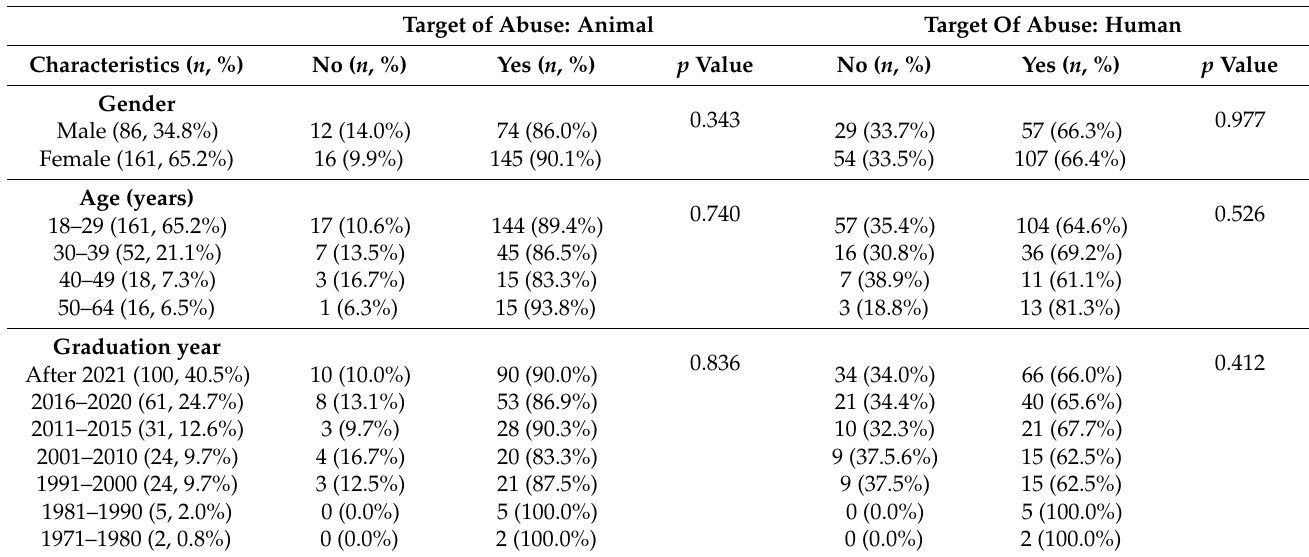
Table 7. Respondents’ demographic characteristics and their attitude toward whether it should be mandatory to report abuse